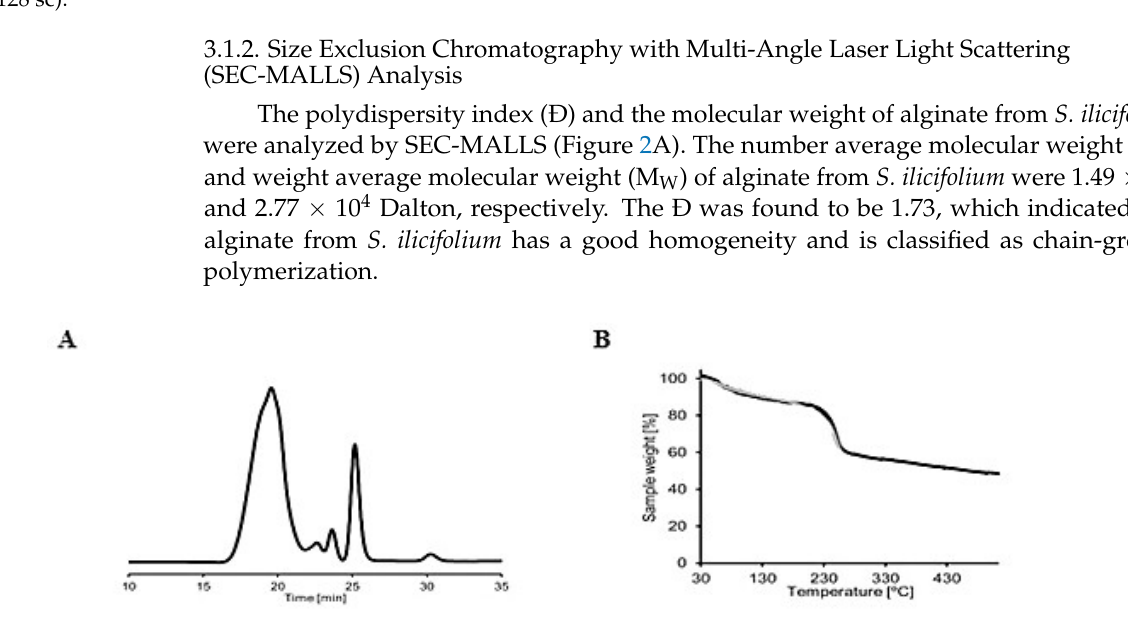
Table 1. Antioxidant activity of alginate, mangosteen rind, and alginate–mangosteen rind combi- nation.